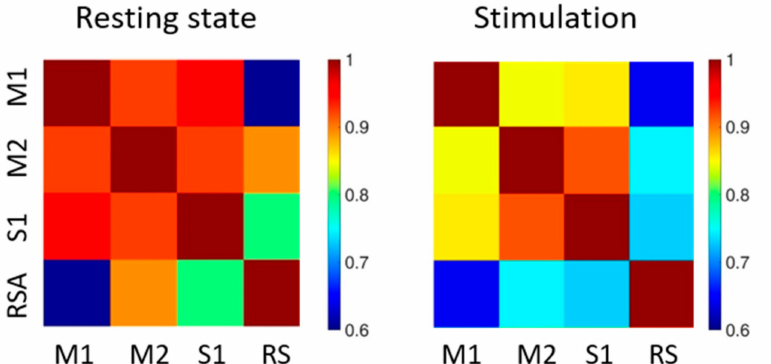
Figure 4. Correlation matrices of functional areas of the cortex. Average correlation matrices during resting state (on the left) and optogenetic stimulation of the contralateral hemisphere (on the right), M1, M2, S1, RS stands for primary motor cortex, secondary motor cortex, primary sensory cortex and retrosplenial area